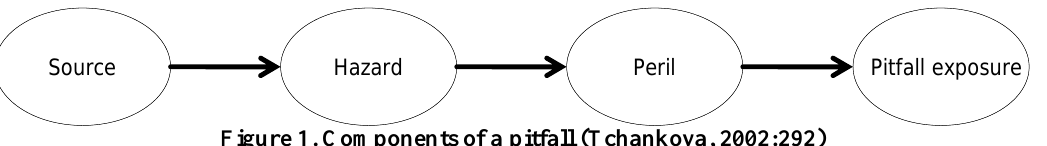
Figure 1. Components of a pitfall (Tchankova, 2002:292)